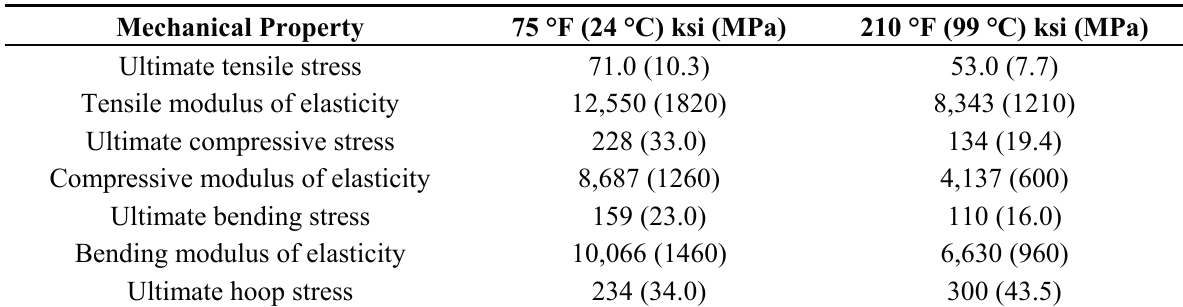
Table 2. Mechanical properties of FRP tube.